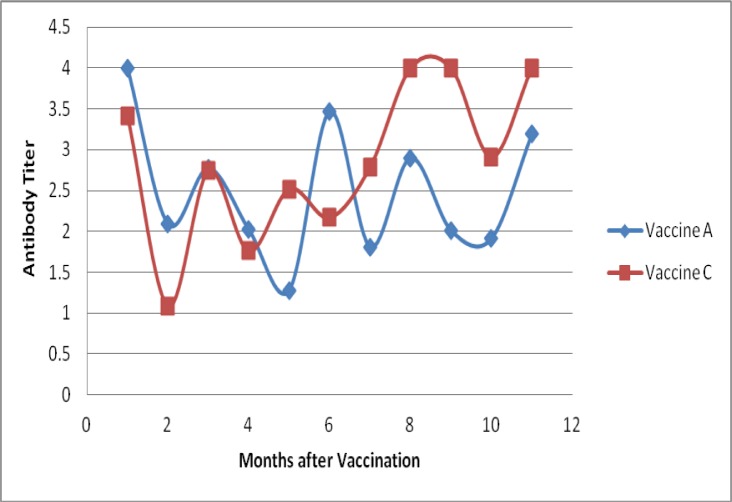
Three commercially available vaccines and the antibody titer in dogs by months after vaccination.* Titre: Rabies antibody Titre. Months: The months after which the samples were collected. A, B, C: Different types of Vaccines used.